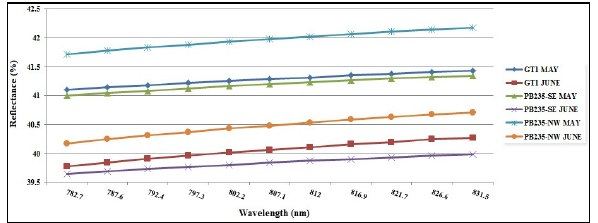
Figura 13. Spectral behaviour in leaf scale, for May and June, in the region of 800nm of the Rubber trees stands: GT1, PB235- SE and PB235-NW